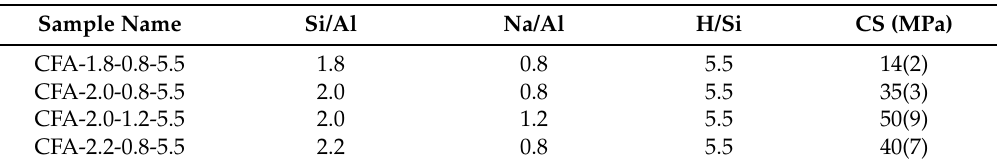
Table 1. Composition and compressive strength (CS) of the geopolymer samples. Calculations of the elemental ratio only consider the amorphous composition of the flyash, i.e., the crystalline component was considered inert and the values indicate the target final composition assuming 100% reaction of the amorphous component of the flyash. The value in the parentheses corresponds to the standard deviation of repeat compressive strength